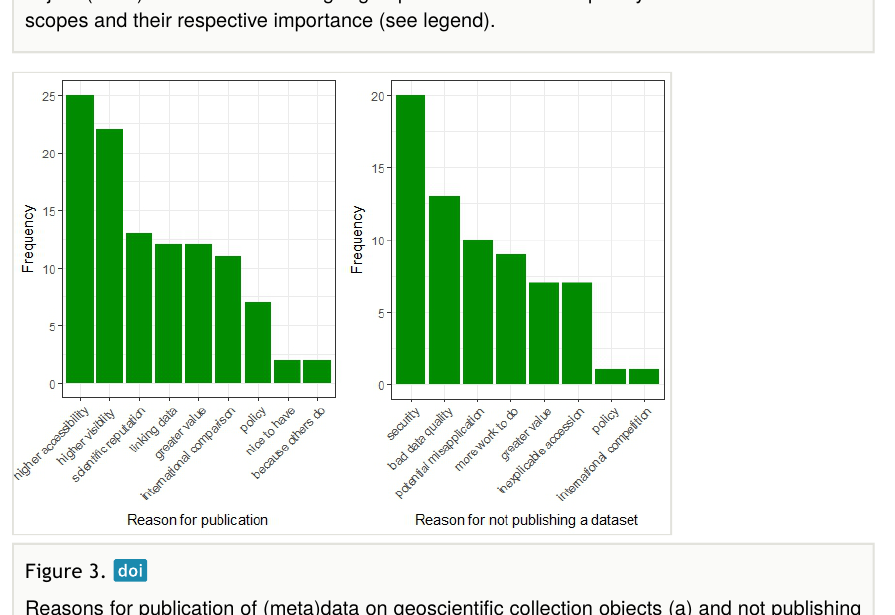
Another question focused on the minimum functionality that a data portal needs to cover and which optional features it could provide in order to increase its value for daily scienti fi c work. Here, multiple di ff erences between each geoscienti fi c sub discipline emerge and several participants emphasize that the minimum information needed depends on the type of collection and scienti fi c task performed.